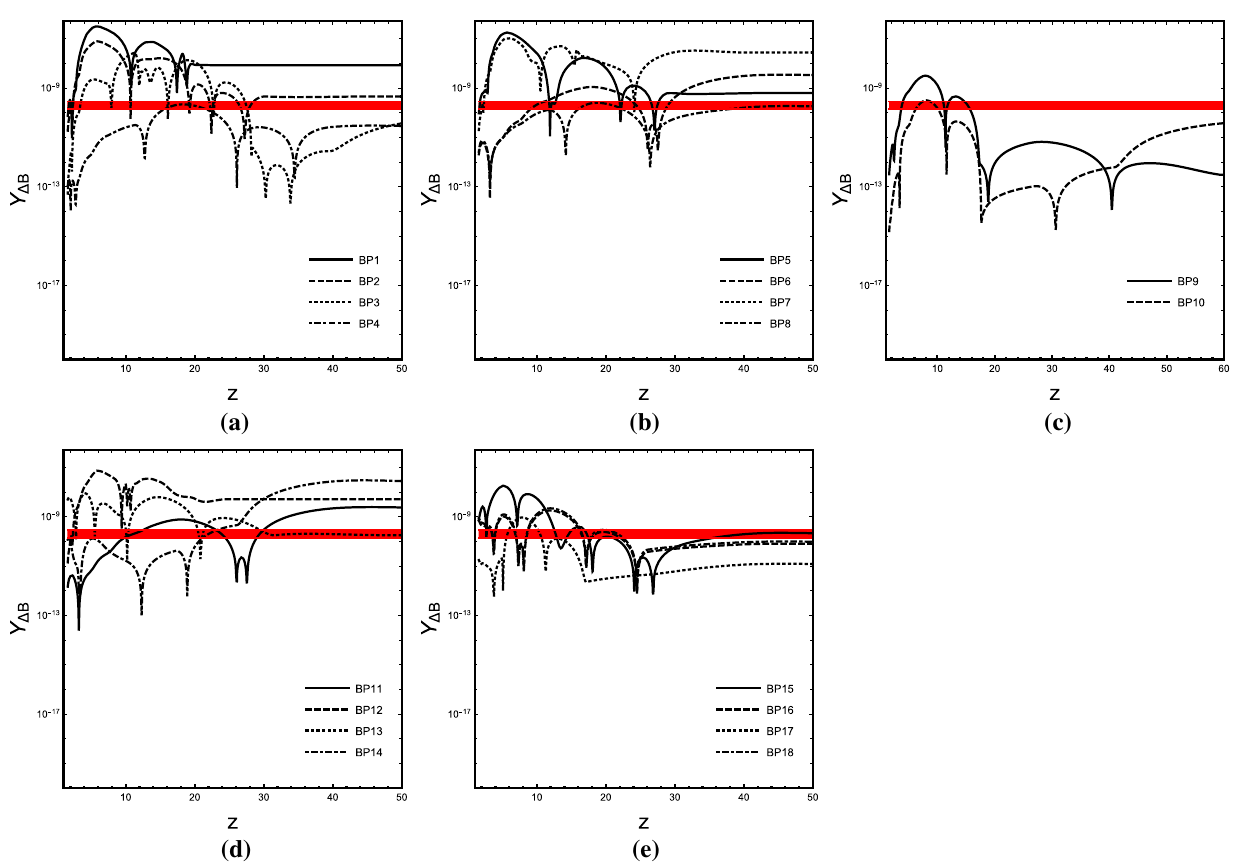
Fig. 3 Plot of Y (cid:4) B versus z = m χ / T shown in a – c with phase φ = π/ 4 for different sets of benchmark points as shown in Table 1. Plot shown in d and e for different sets of benchmark points as shown in Table 2. The red horizontal line corresponds to required approximate baryonic asymmetry